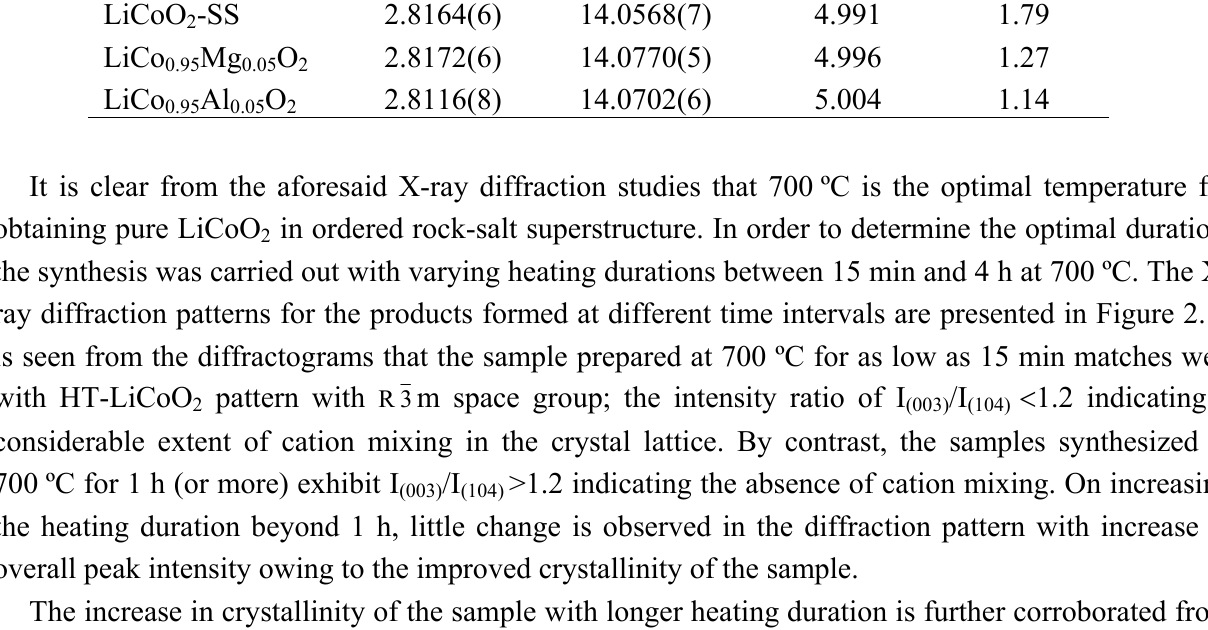
/I intensity ratio for HT-LiCoO (003) (104)